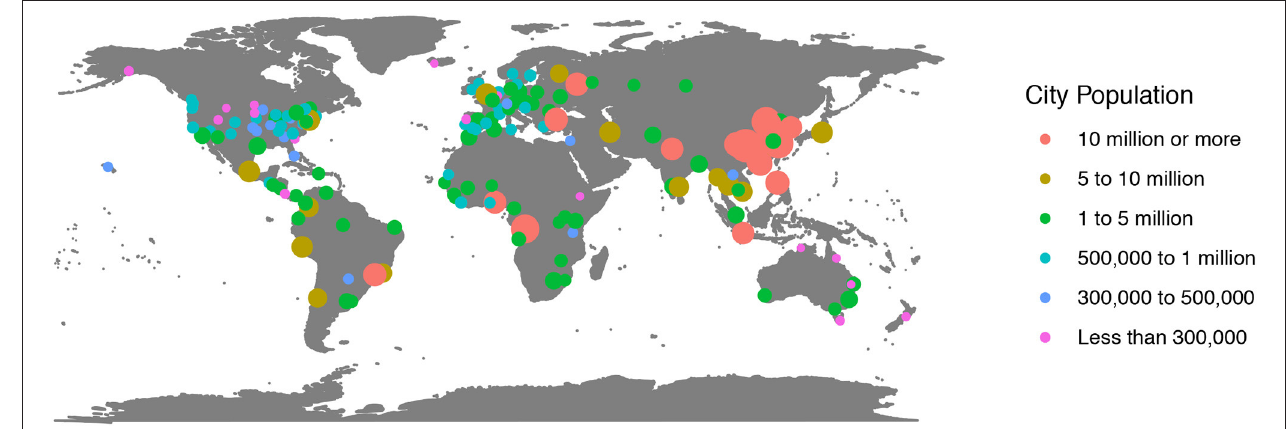
FIGURE 1 | UESI cities by population